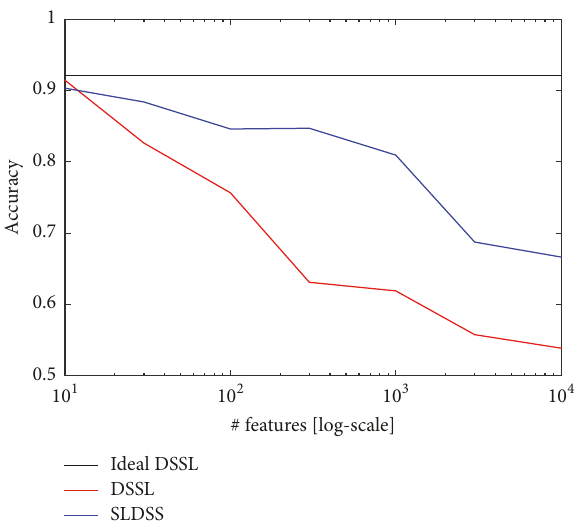
Figure 3: Synthetic experiment. Influence of the sample size (number of sample pairs) on the accuracy of ranking